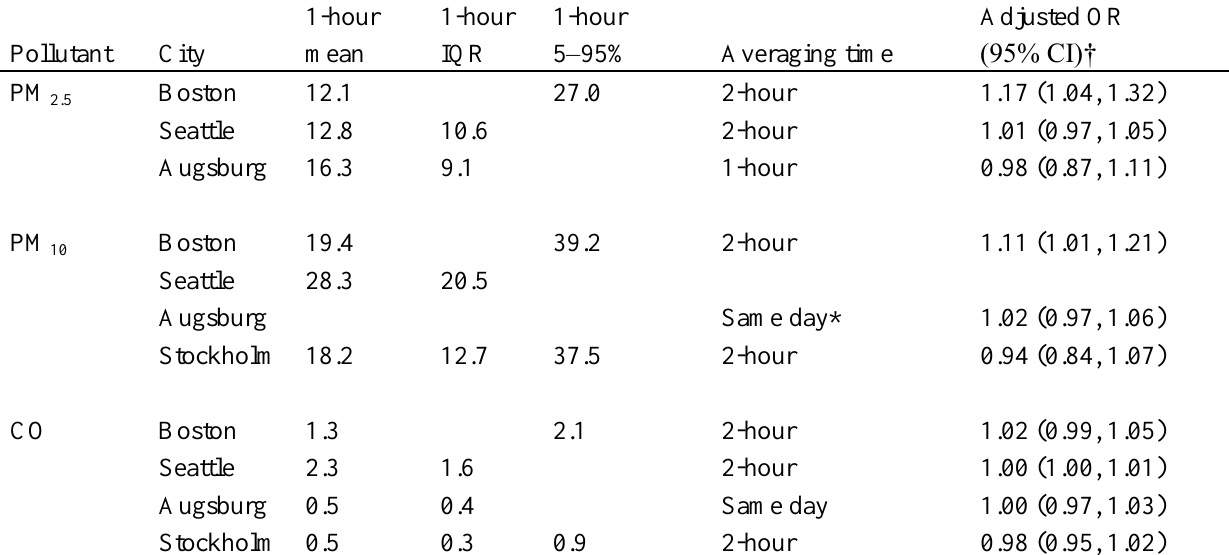
Table 5. Air pollution profiles and effect estimates for air pollution on onset of myocardial infarction. A comparison of four